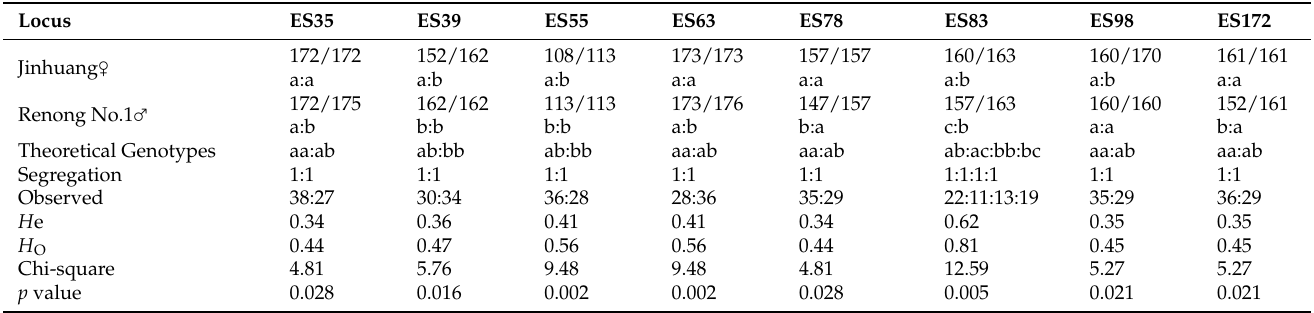
Table 3. Genotypes of eight SSR molecular makers for two parents (‘Jinhuang’